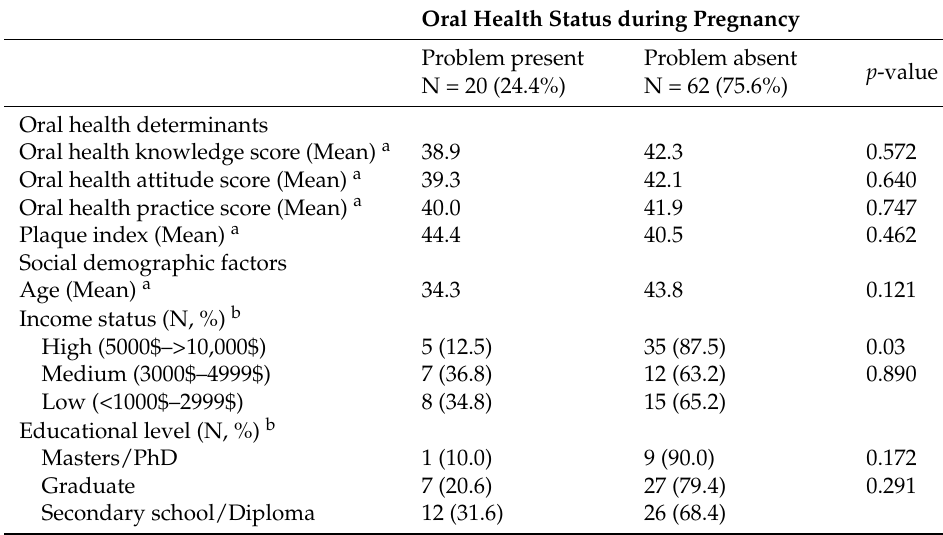
Table 3. Association of oral health status with oral health determinant factors and social demographic factors (N =